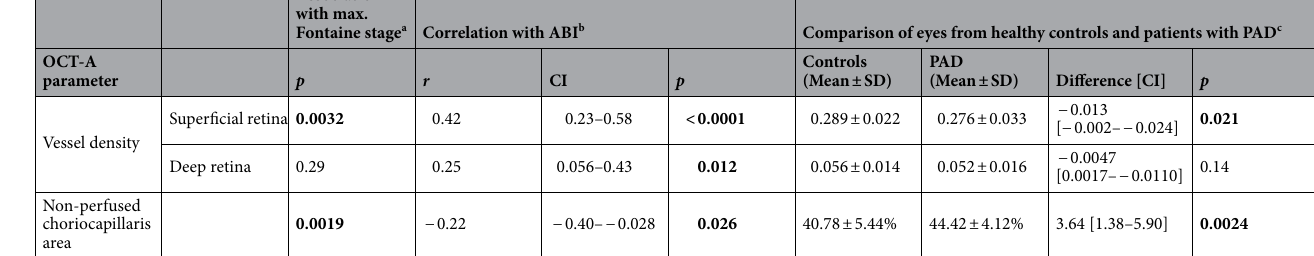
Table 2. Analysis of OCT-A parameters. a Kruskal–Wallis test; b Pearson correlation; c t-test / Wilcoxon rank sum test; ABI = ankle-brachial-pressure-index; CI = confidence interval; OCT-A = optical coherence tomography angiography; PAD = peripheral arterial disease.